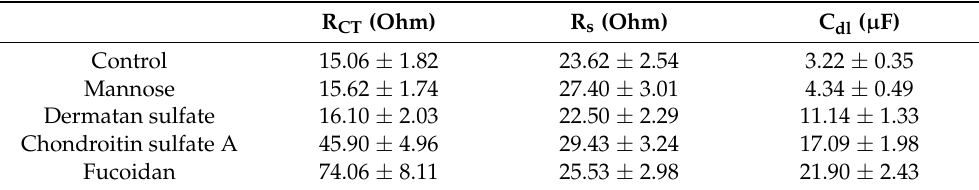
Table 1. Summary for the simulation of EIS fitting process according to the Randles equivalent circuit, in which the binding of GAGs with the surface-bound Lcl proteins was monitored on a gold CD chip surface. Blank samples contained 0.01 M HEPES buffer solution (pH 7.4), including 0.15 M NaCl, 0.05